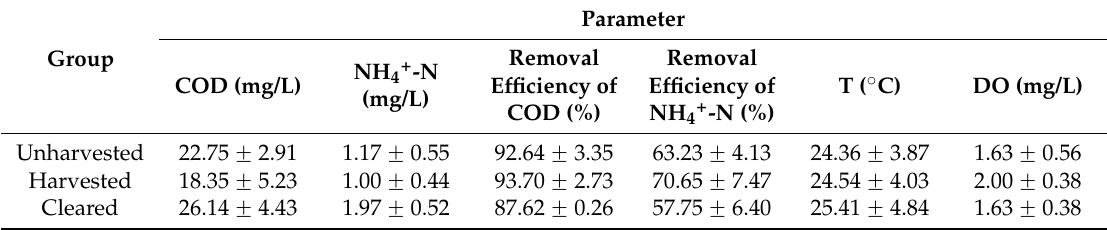
Table 1. The effluent characteristics in different groups (mean ˘ SD, n = 3). DO, dissolved